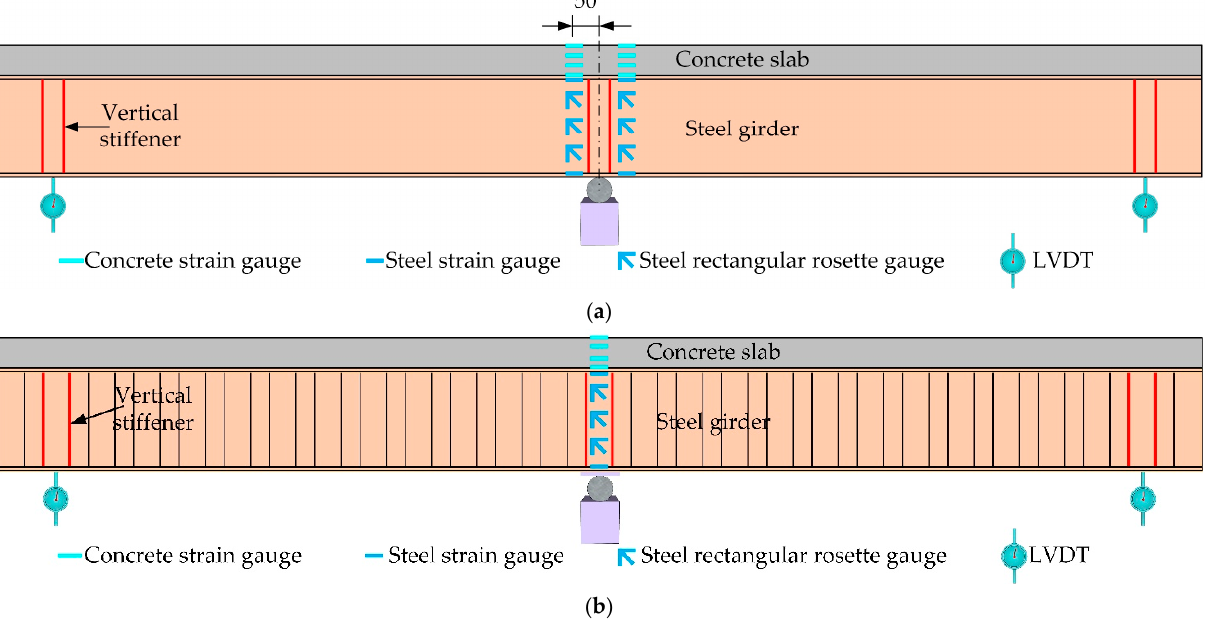
Figure 4. Arrangement of measuring points: ( a ) Composite girders with flat webs; ( b ) Composite girders with corrugated webs (unit: